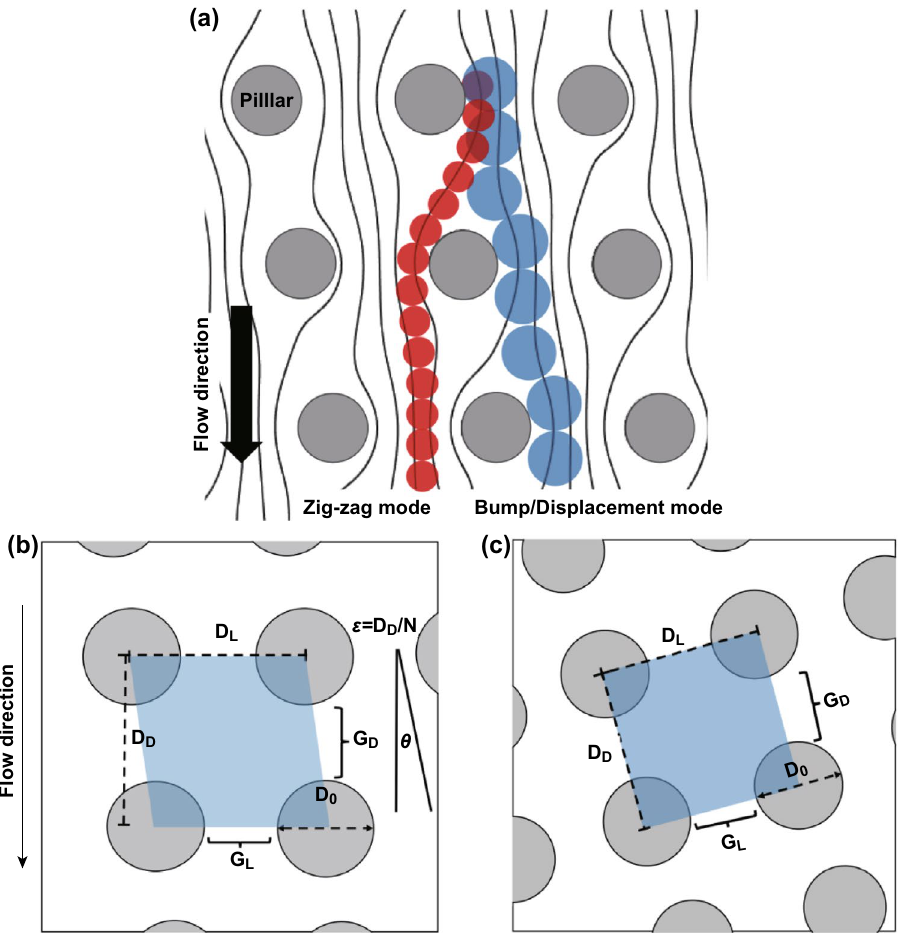
Fig. 2 Fundamental of DLD. a Deterministic lateral displacement principle: small particles whose sizes are less than the critical diameter move in a zigzag direction, while large particles travel in bumping mode. b The parallelogram array layout design and c the rotated square array with the design parameters on each of the DLD unit cell. ( D L , D D ): center-to-center pillar distance in the lateral and downstream directions, N : array period, θ : the angle of the tilted array relative to the flow